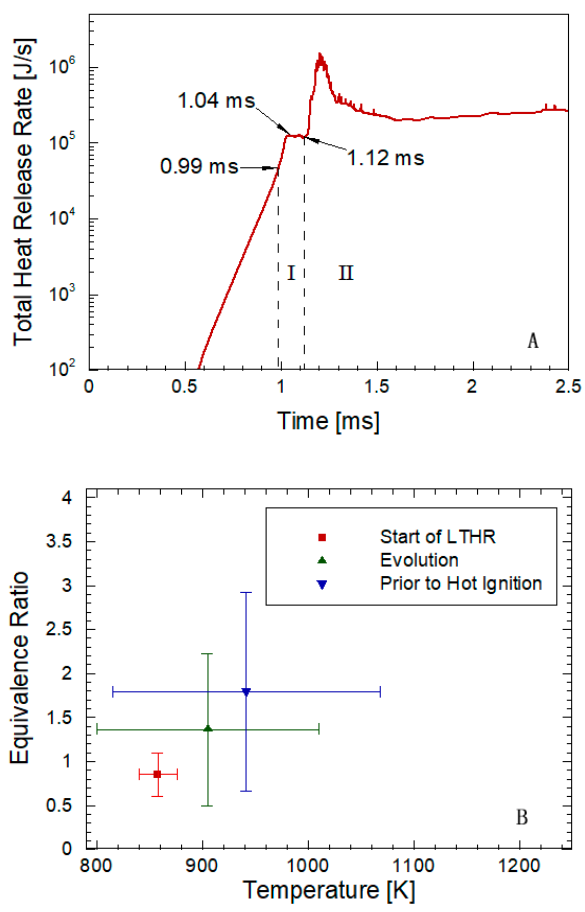
Figure 10. Schematic representation of the evolution of the total HRR ( A ) and the exothermic region ( B ) at 850 K for a nozzle diameter of 0.15 mm.